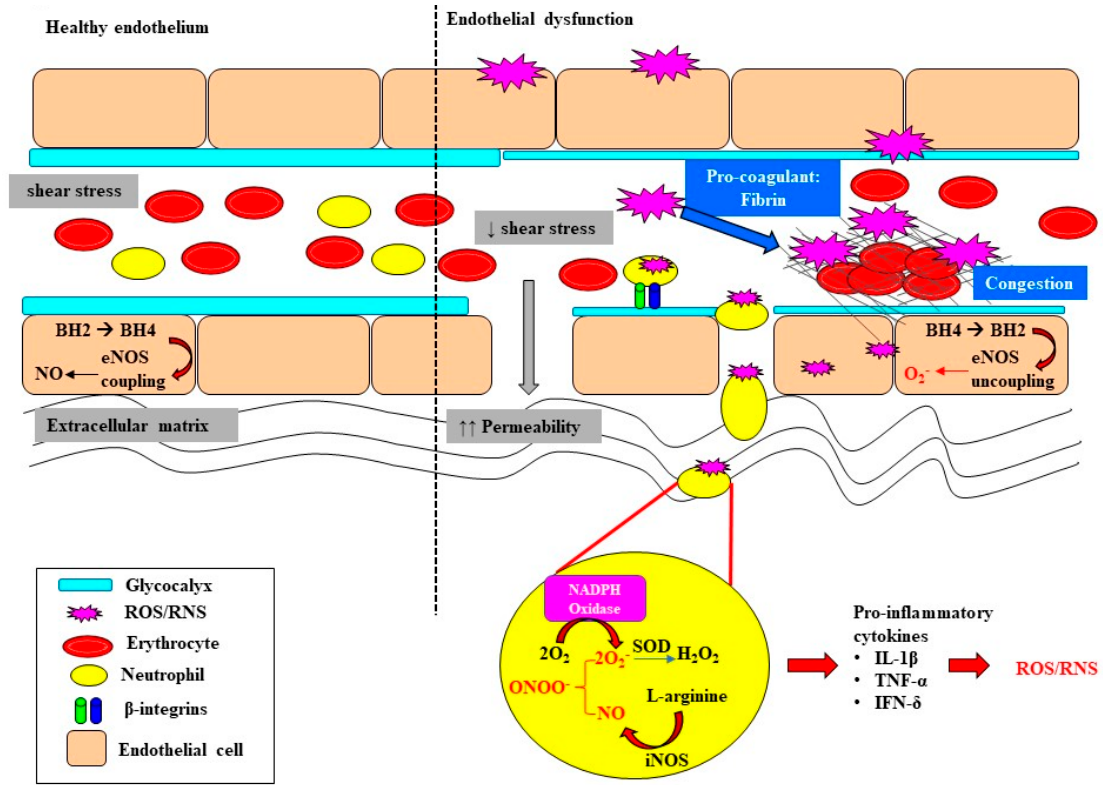
Figure 2. A schematic outlining the initiation of oxidative damage to the endothelium, the downstream consequences for endothelial dysfunction and the propagation of oxidative stress. The layer of glycocalyx lining the apical surface of endothelial cells is important for the maintenance of shear-stress and flow-mediated nitric oxide (NO) release and vasodilation of the endothelium. Sepsis-induced oxidative stress leads to glycocalyx thinning and shedding, resulting in the loss of gap junctions, and subsequently increased permeability and vascular leakage. Loss of gap junctions also greatly facilitates extravasation of neutrophils in the circulation, mediated by β -integrins, through to the extracellular matrix. The resultant superoxide (O 2 − ) that is formed can interact with nitrosative species generated by inducible nitric oxide synthase (iNOS), forming the highly reactive peroxynitrite (ONOO − ) and then hydrogen peroxide (H 2 O 2 ). Oxidative bursts from neutrophils contribute to enhanced oxidative damage and the downstream production of pro-inflammatory cytokines which have the intrinsic capability of producing reactive oxygen species (ROS) and reactive nitrogen species (RNS). Oxidative stress can also induce the recruitment of pro-coagulants to the site of injury, resulting in vascular congestion, ultimately impeding blood flow. Increased oxidative stress at the endothelium depletes and oxidizes the pool of tetrahydrobiopterin (BH4), resulting in the uncoupling of endothelial nitric oxide synthase (eNOS) in endothelial cells, thereby enhancing the production of ROS. Interleukin-1beta (IL- β ); tumor necrosis factor-alpha (TNF- α ), interferon-gamma (IFN- δ ).